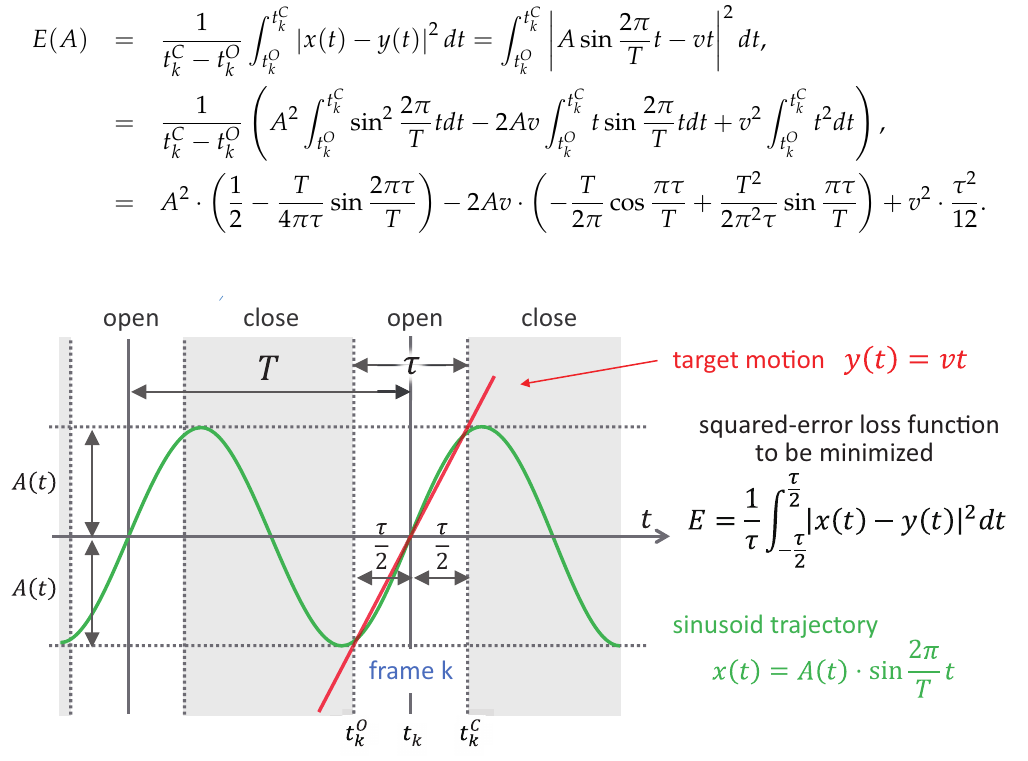
Figure 4. Sinusoid trajectory and its approximate straight